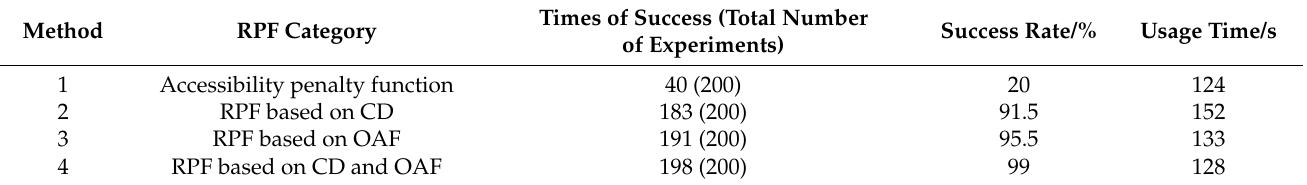
Table 2. The effect of different RPF.